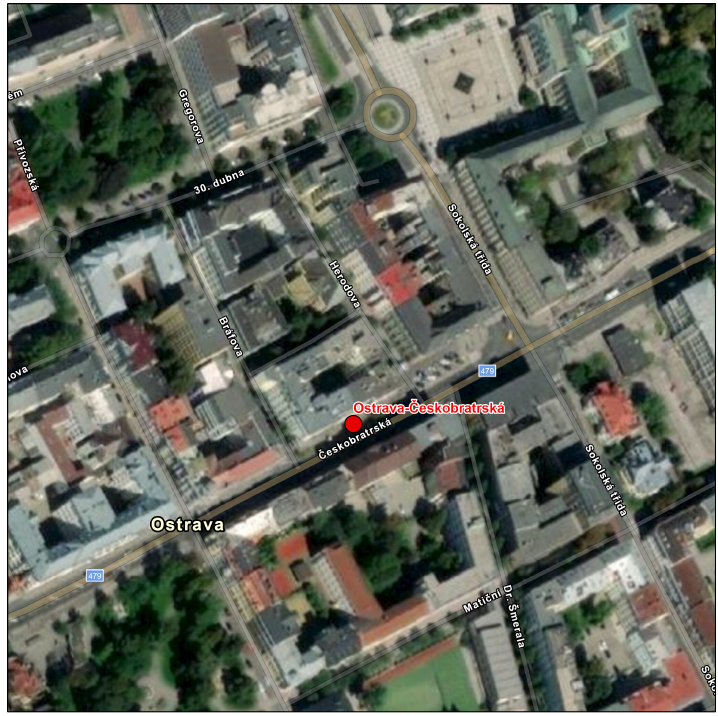
Figure A1. Location of the Ostrava- ˇCeskobratrská station.